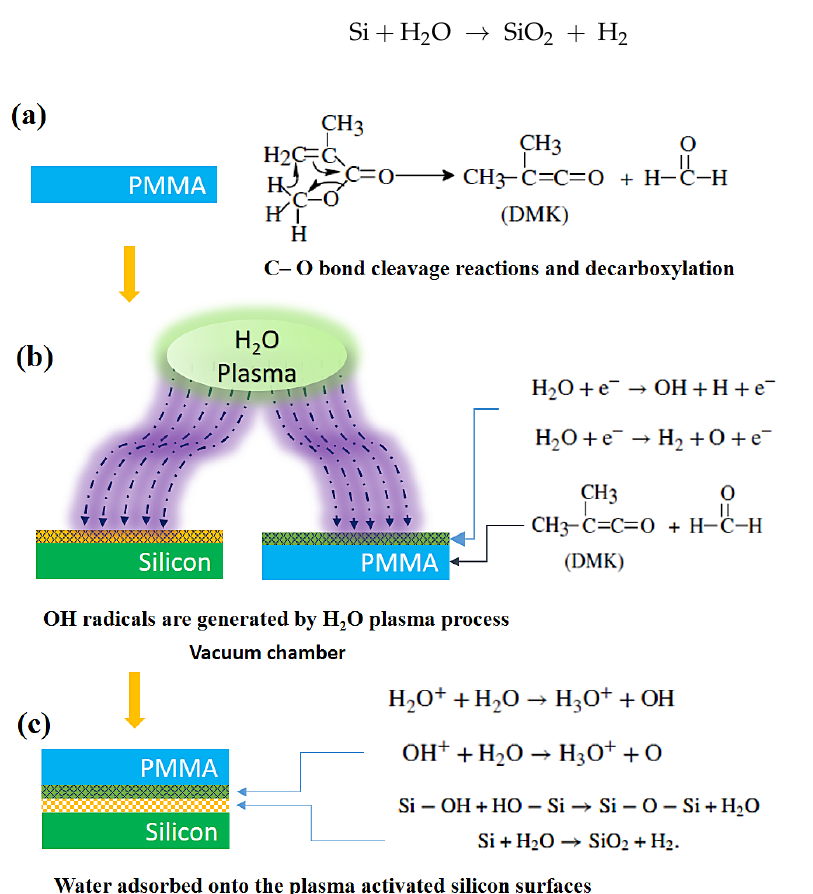
Figure 3. Process flow diagram for bonding between PMMA/silicon substrates. ( a ) Chemical structures of the PMMA substrates. ( b ) Schematic illustration of the chemical reaction caused by the incorporation of H 2 O plasma in the bonding process on the surface of the substrates. ( c ) Chemical reaction anticipated to occur on the surfaces of the PMMA and silicon substrates after H 2 O plasma treatment, resulting in bonded H 2 O–OH + radicals.